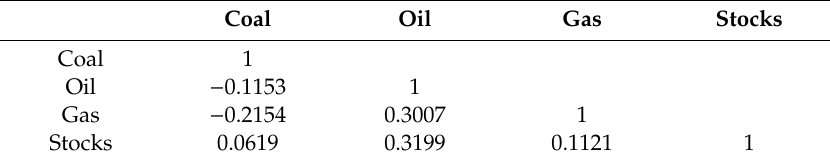
Table 16. Correlations for Norway.